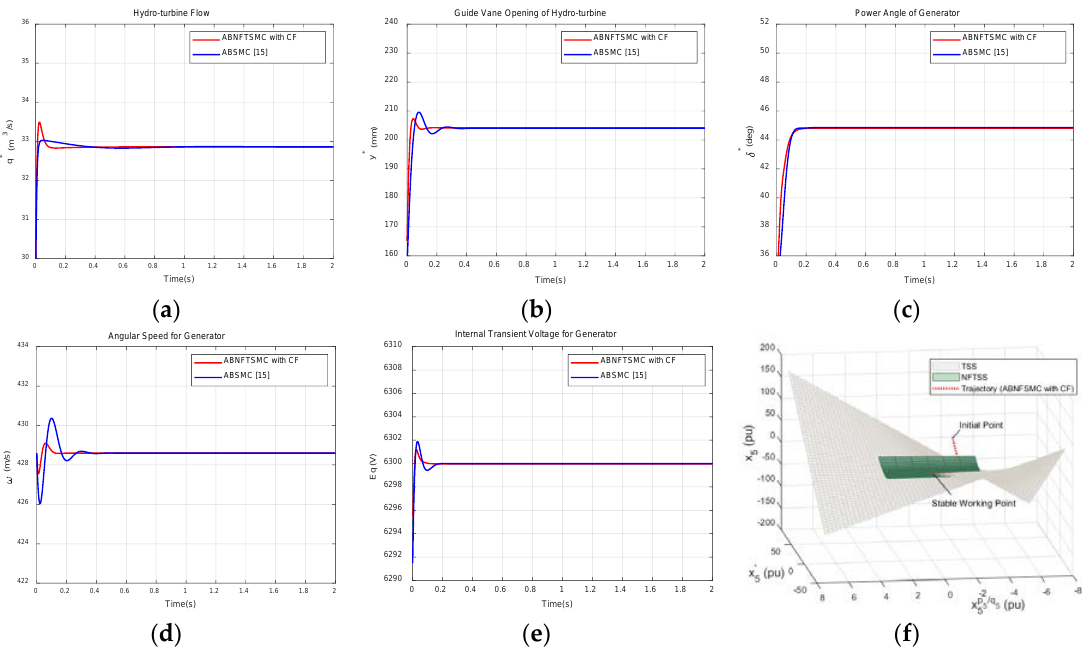
Figure 6. Responses in the scenario of stochastic intensity D = 0.01 of water flow. ( a ) the hydro-turbine flow; ( b ) the guide vane opening for hydro-turbine; ( c ) the power angle for generator; ( d ) the angular speed for generator; ( e ) the internal transient voltage for generator; ( f ) phase trajectory of Sbsystem 5 for NFTSS and TSS.